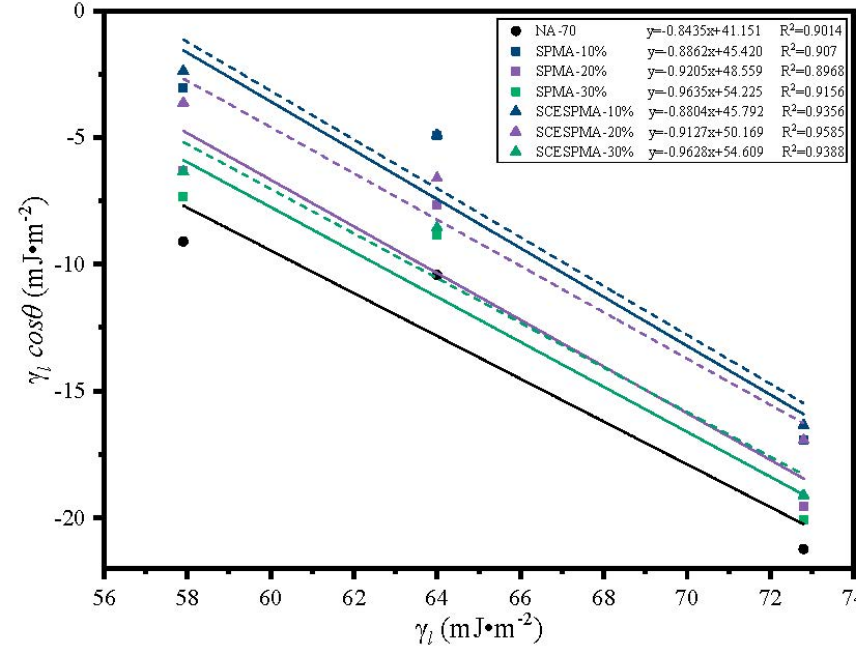
Figure 16. Relationship between γ l and γ l cos θ .